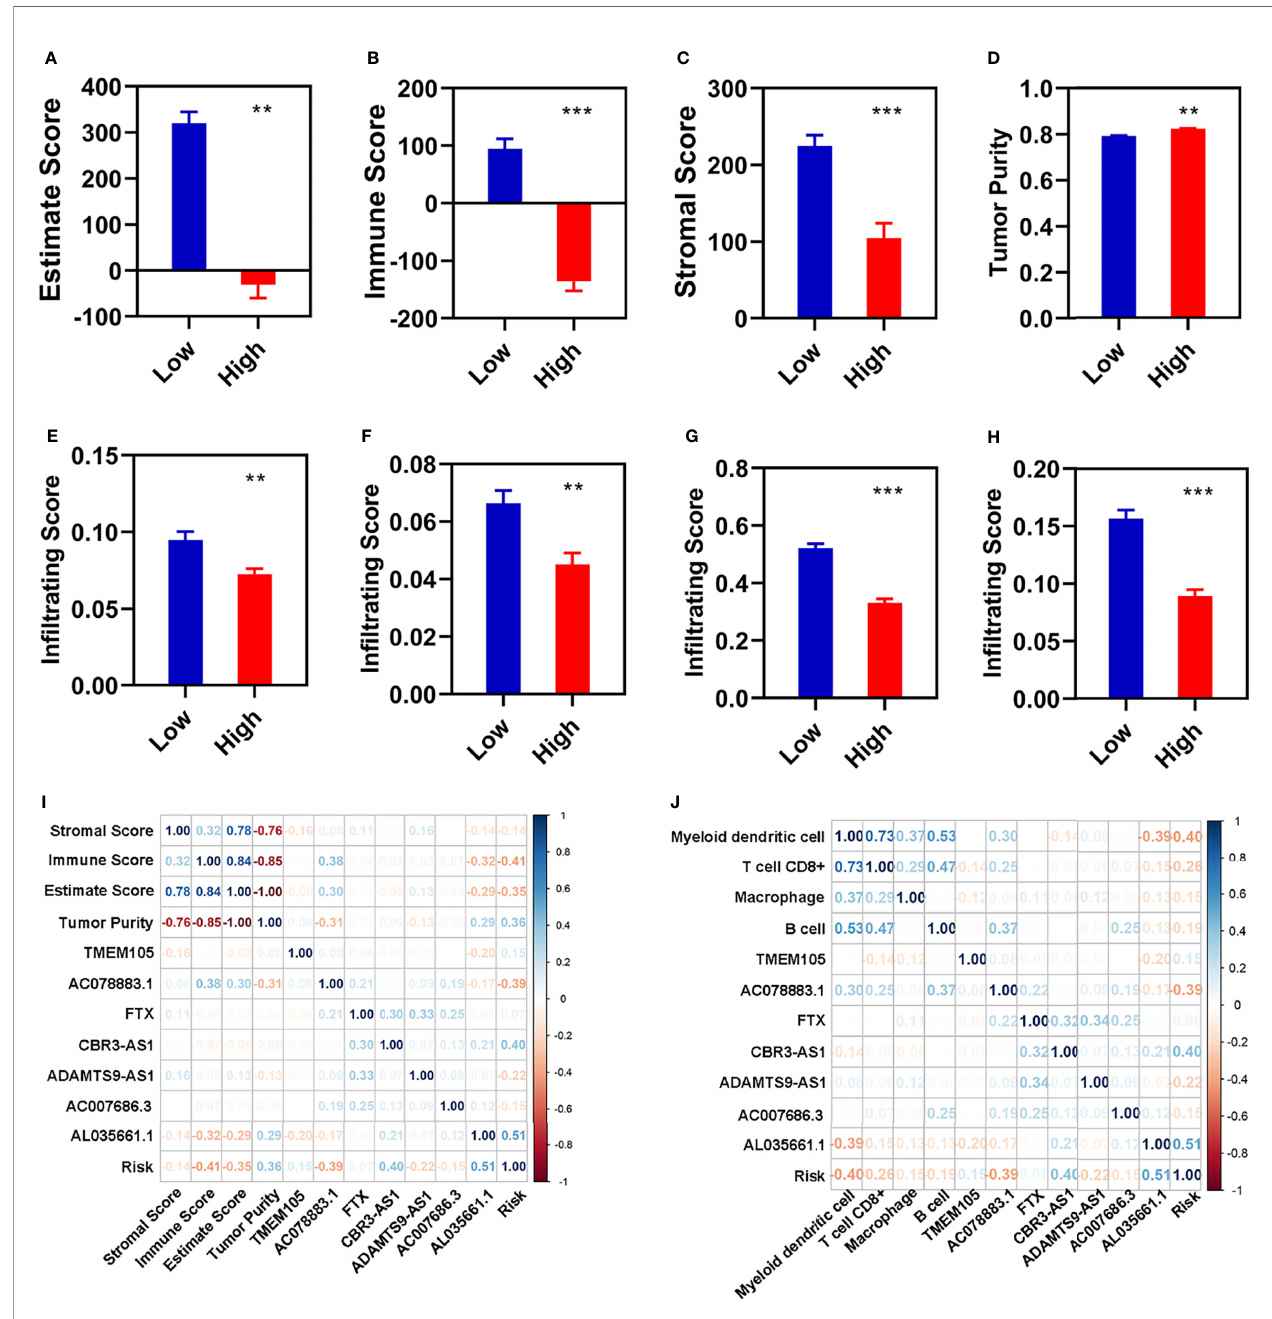
FIGURE 4 | Correlation analyses of risk assessment model with the immunity. (A – D) Comparison of the estimate score (A) , immune score (B) , stromal score (C) , and tumor purity (D) between the patients with different risk value. (E – H) Comparison of the in fi ltrating score between the patients with different risk value. (E) B cell. (F) Macrophage. (G) Myeloid dendritic cell. (H) T cell CD8 + . (I, J) Correlation analyses of these seven FI-DELs with the ESTIMATE score (I) and in fi ltrating score (J) . **p < 0.01, ***p <